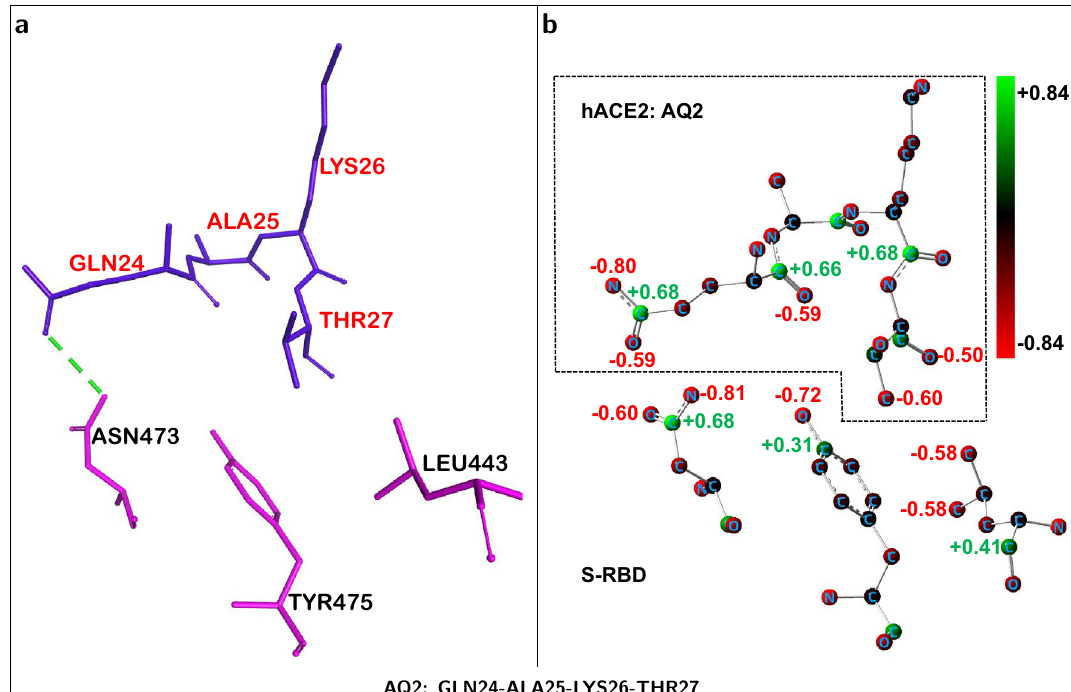
Figure 4. hACE2-centered fragment producing a net repulsive interaction towards S-RBD. ( a ) ACE2 quartet residues (shown in blue) and neighboring S-RBD residues (shown in pink) corresponding to a repulsive ACE2...S-RBD interaction. ACE2 is used as the structural reference. ( b ) Corresponding residue atoms displaying positive charge (green spheres) or negative charge (red spheres). Atomic partial charges, evaluated with NBO 33 method, for selected atoms are shown. The electrostatic hACE2...S-RBD interface, for this fragment, is dominated by negatively charged (red) atoms leading to a net intermolecular repulsion. Positively charged hydrogen atoms not shown.